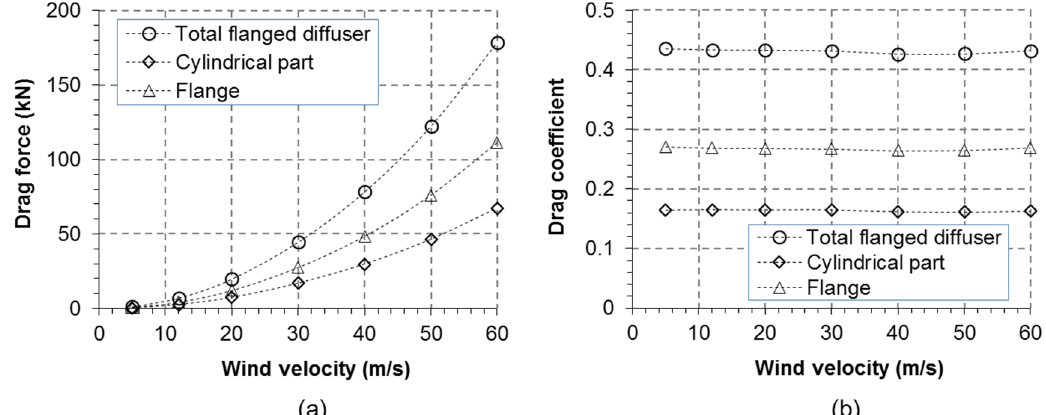
Figure 12. Comparison of the drag forces ( a ) and drag coefficients ( b ) among the flange, the cylindrical part, and the total flanged diffuser obtained from the CFD analyses for the diffuser with a rigid and flat flange (Figure 8a) at various